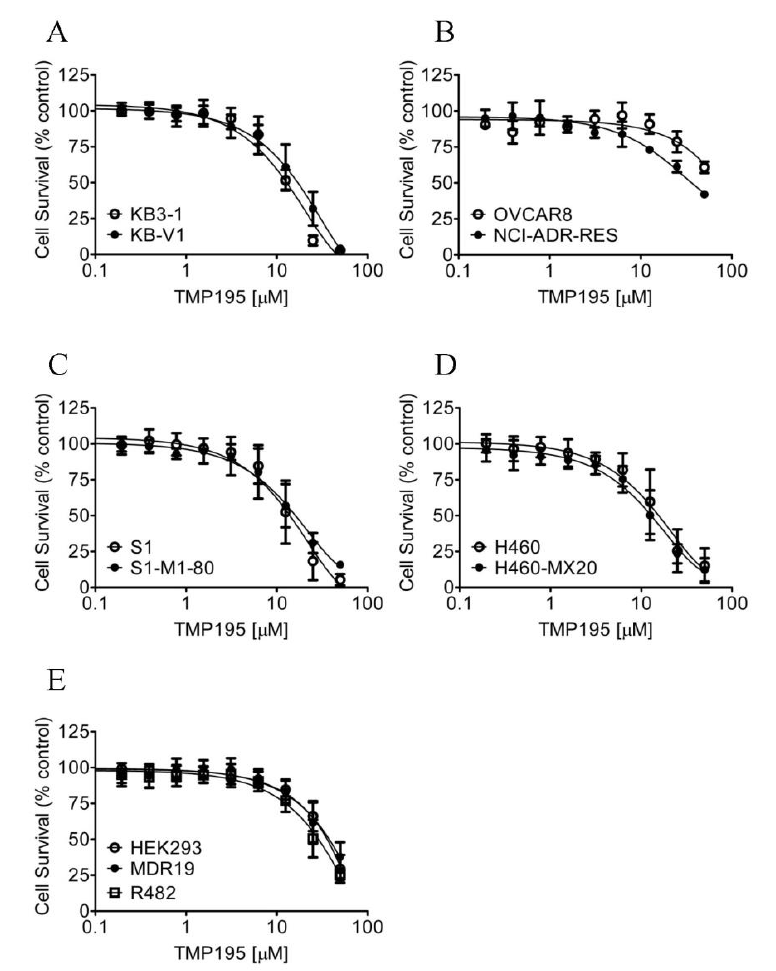
Figure 6. Drug-sensitive parental and multidrug-resistant cells overexpressing ABCB1 or ABCG2 are equally sensitive to TMP195. The cytotoxicity of TMP195 was determined in ( A ) drug-sensitive human epidermal cancer cell line KB-3-1 (open circles) and KB-V-1, the ABCB1-overexpressing multidrug-resistant variant (filled circles), ( B ) drug-sensitive human ovarian cancer cell line OVCAR-8 (open circles) and NCI-ADR-RES, the ABCB1-overexpressing multidrug-resistant variant (filled circles), ( C ) drug-sensitive human colon cancer cell line S1 (open circles) and S1-M1-80, the ABCG2-overexpressing multidrug-resistant variant (filled circles), ( D ) drug-sensitive human lung cancer cell line H460 (open circles) and H460-MX20, the ABCG2-overexpressing multidrug-resistant variant (filled circles), as well as ( E ) parental pcDNA-HEK293 cells (open circles) and HEK293 cells transfected with human ABCB1 (MDR19-HEK293, filled circles) or human ABCG2 (R482-HEK293, open squares). Points, mean values from at least three independent experiments; error bars; SD.